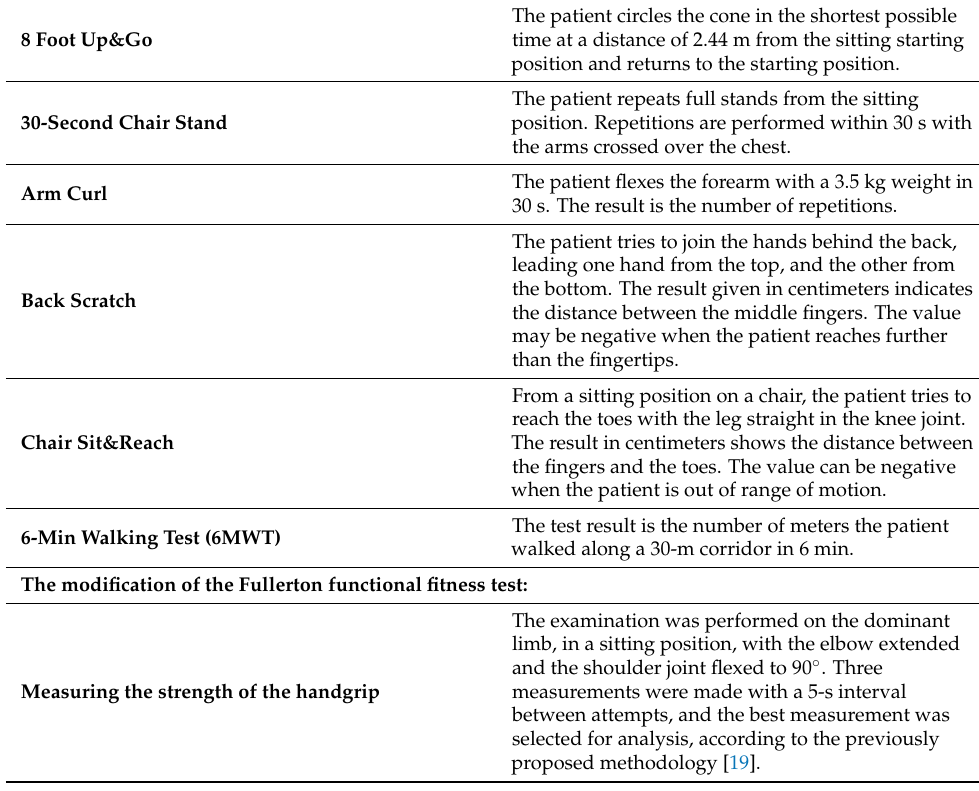
Table 2. Six motor tasks assessed in the Fullerton functional fitness